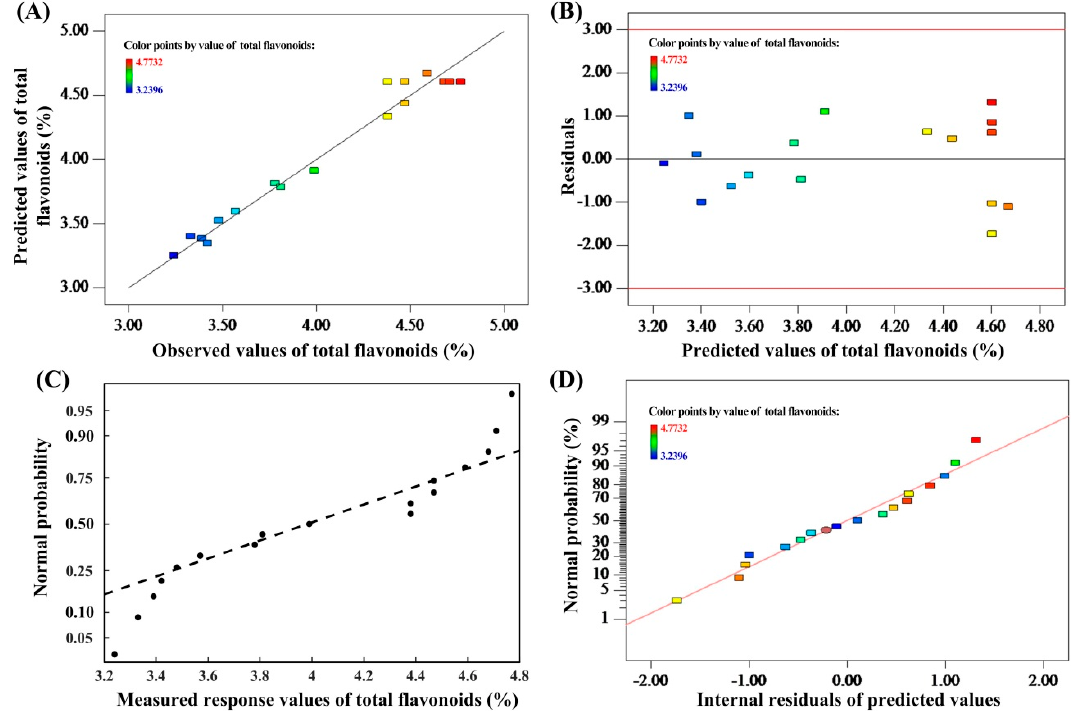
Figure 1. Plot of predicted vs observed values of the total flavonoids ( A ); the plot of the residuals versus the predicted response ( B ); the normal probability for the measured response values ( C ); Normal probability plots of residuals ( D ).